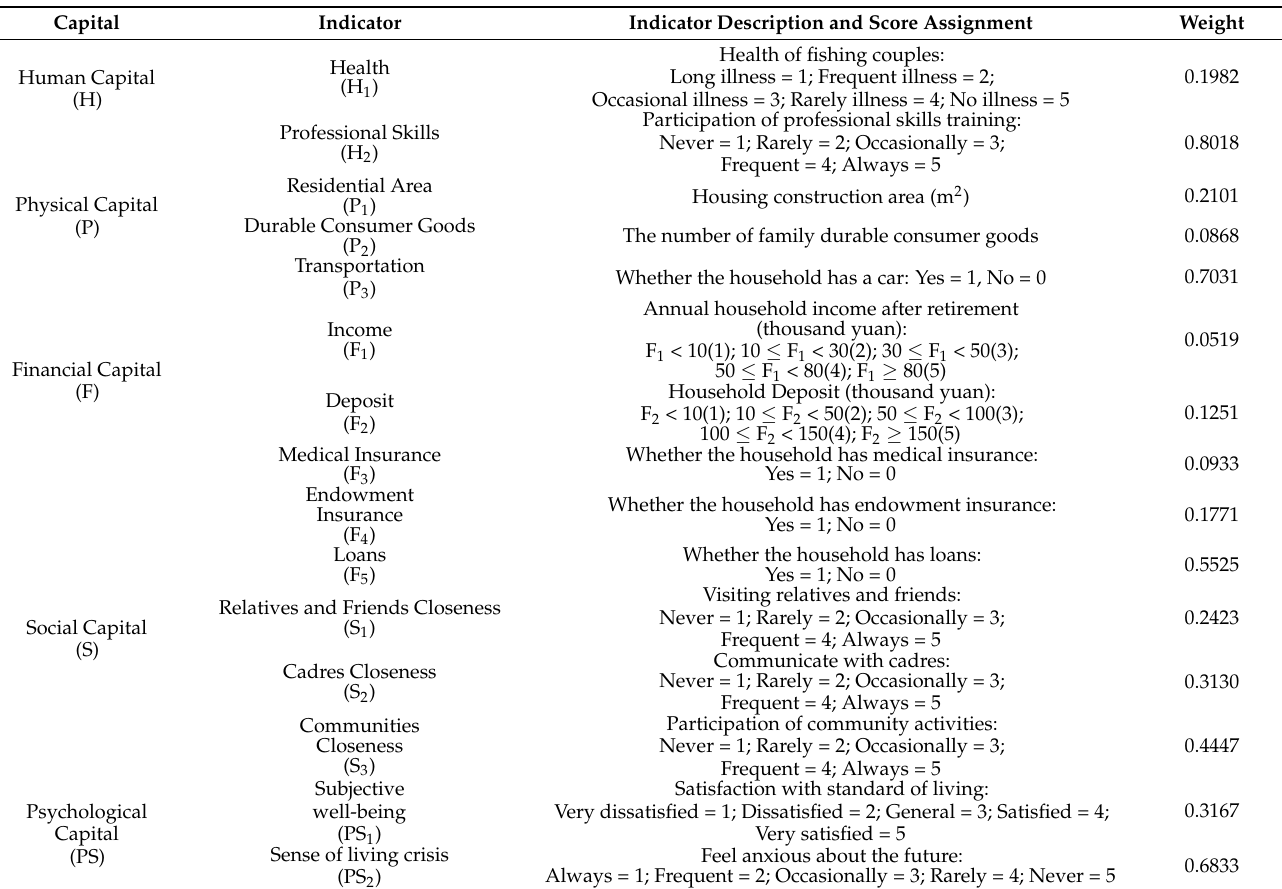
Table 1. Evaluation system of the retired fishermen’s livelihood capital